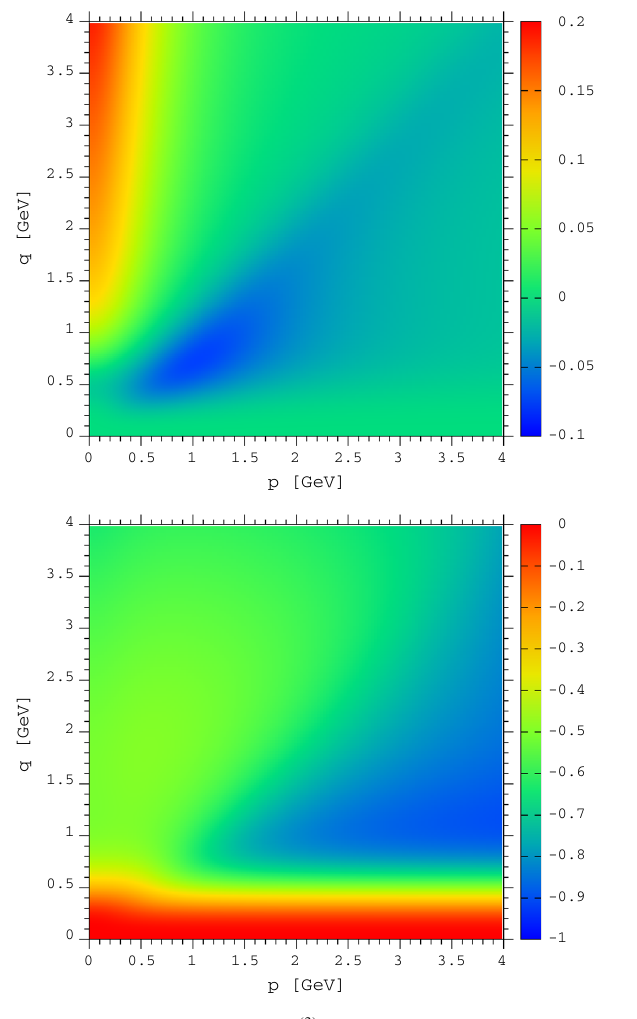
( p , q ) and vector (bottom) B